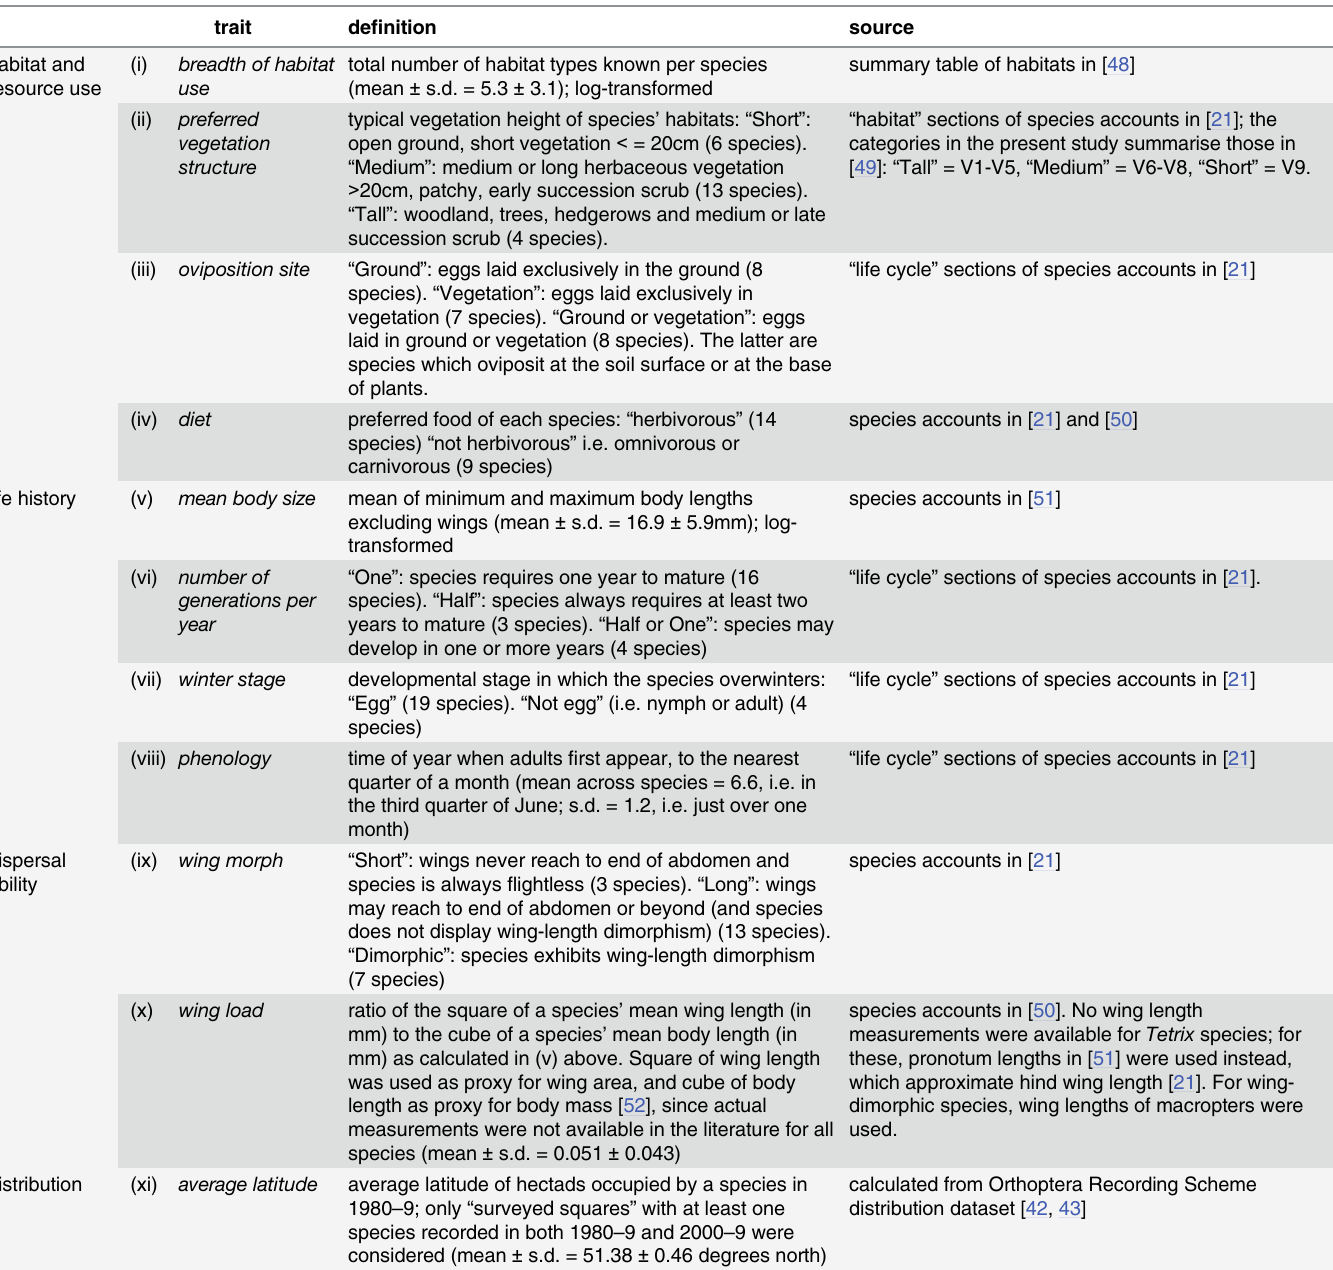
trait breadth of habitat